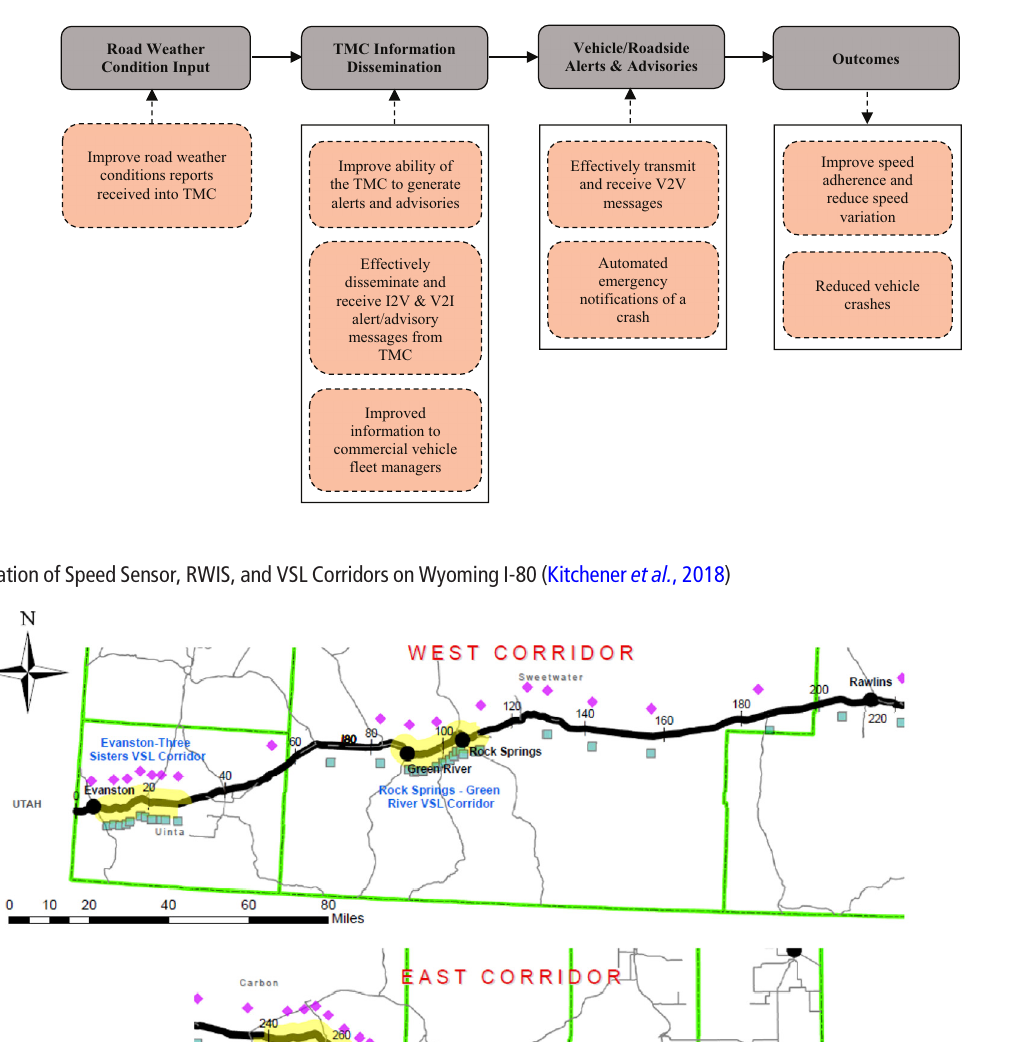
Figure 8 Architecture of the Proposed Performance Measure Categories (Adapted from Kitchener et al. , 2018)